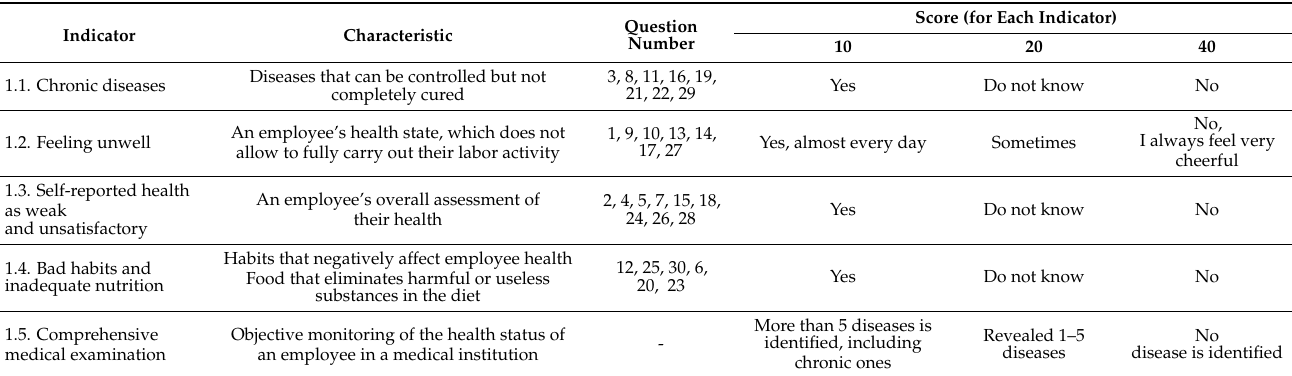
Table 6. Employee health quality assessment: description of the assessment tool, questions for questionnaire (a typical questionnaire is presented in Appendix A) and score.